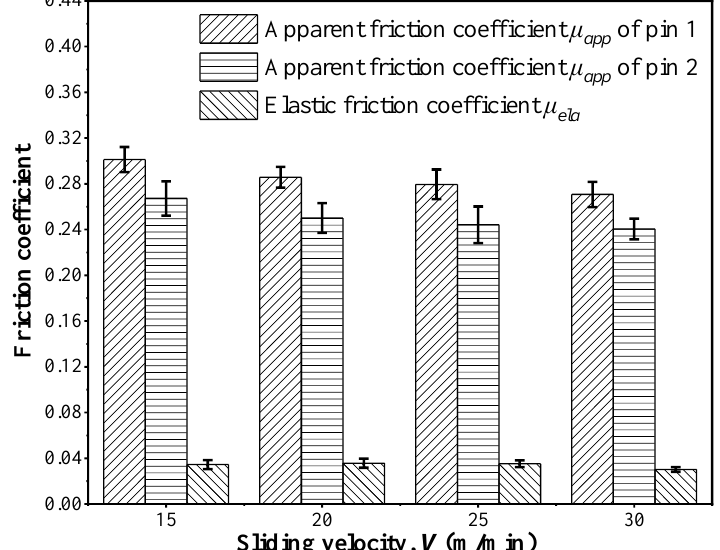
Figure 6. The apparent friction coefficients of the two pins and the elastic friction coefficients vs. the sliding velocity.